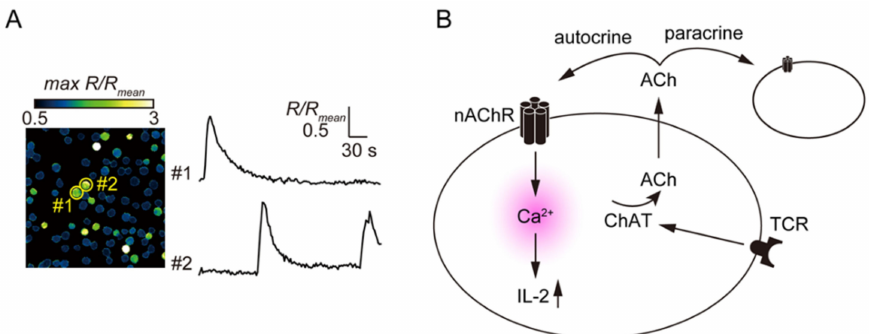
Figure 4. Autocrine ACh acts via nAChRs to elicit [Ca 2+ ] i transients in MOLT-3 cells. ( A ) Spontaneous increases in [Ca 2+ ] i within MOLT-3 cells during a 5-min observation period. Representative traces showing the spontaneous [Ca 2+ ] i responses. Reproduced with permission from [61]. ( B ) ACh synthesized by ChAT and then released from T cells activates nAChRs on the surfaces of themselves or neighboring cells, which results in transient [Ca 2+ ] i increases and IL-2 synthesis. TCR activation enhances the autocrine action of ACh by mediating increased ChAT